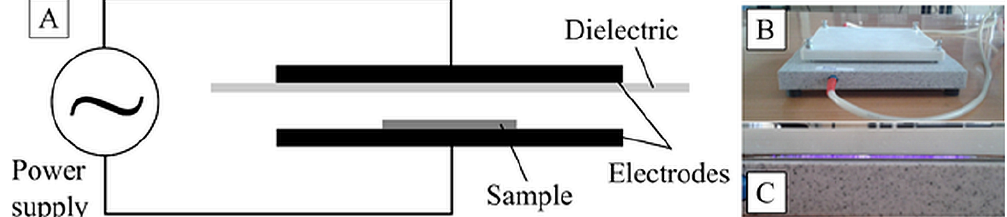
Figure 2. DBD plasma reactor: schematic view of the DBD configuration ( A ), a model of the plasma reactor ( B ), electrical discharges (i.e., nonthermal plasma) in the reactor ( C ).